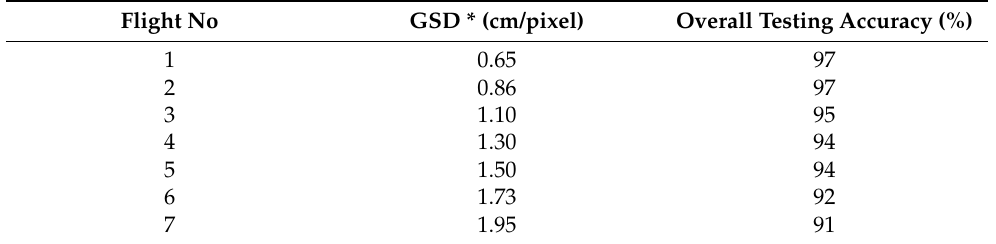
Table 11. Overall testing accuracy report arising from the use of the XGB model to detect hawkweed foliage at different spatial resolutions at the study